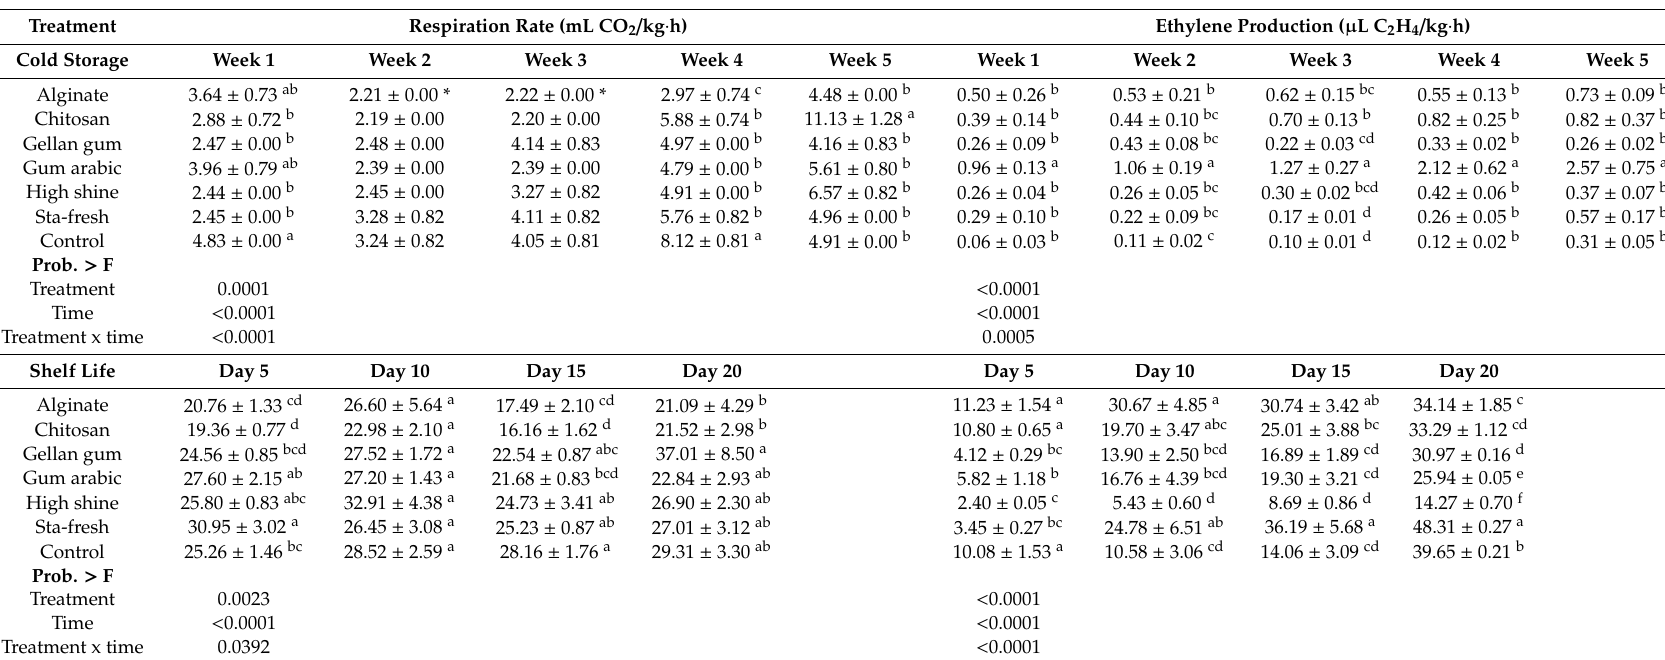
Table 2. Physiological responses in plums (‘African Delight ™ ’) during a simulated shipping period (cold storage; − 0.5 ± 2 ◦ C and 90 ± 5% RH for 5 weeks) and shelf life (20 ± 2 ◦ C and 75 ± 5% RH for 20